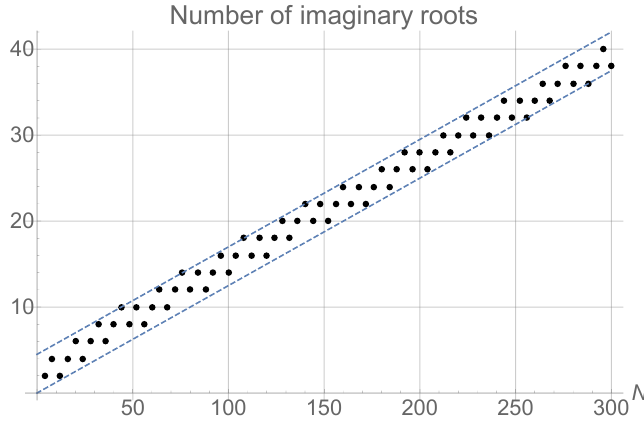
Figure 5: Number of imaginary Bethe roots and the bounds N